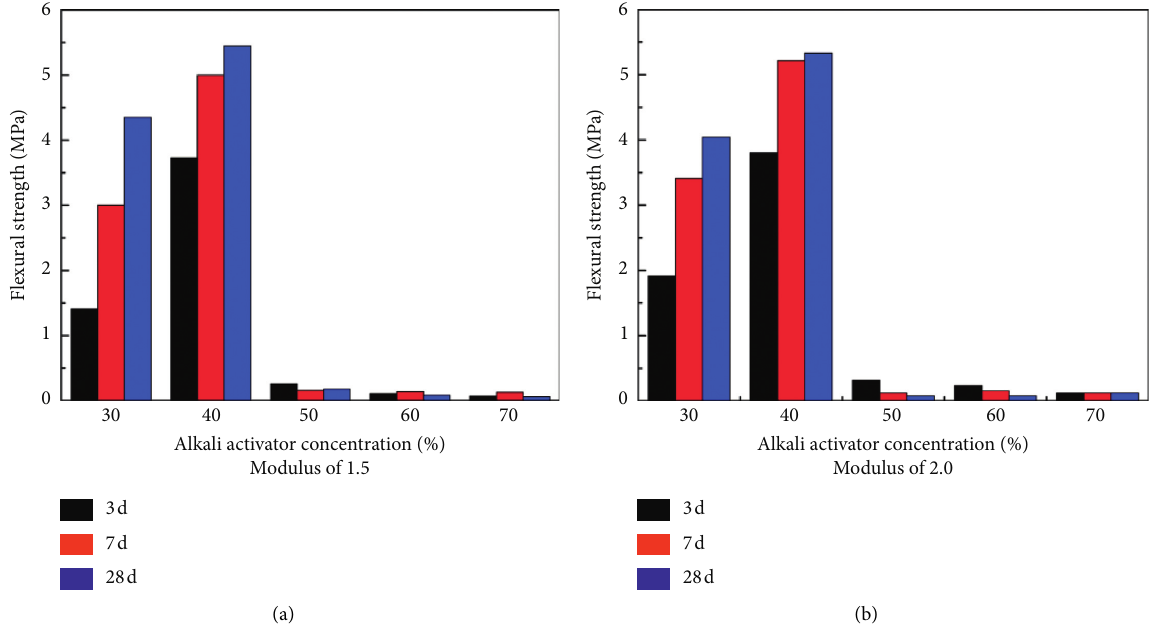
Figure 3: Influence of activator concentration on geopolymer flexural strength.